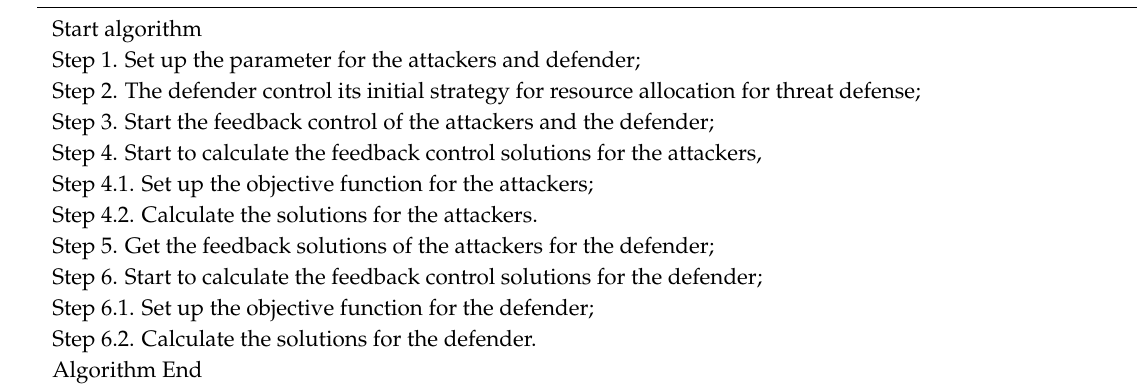
Algorithm 2. Feedback control algorithm for the attackers and defender.